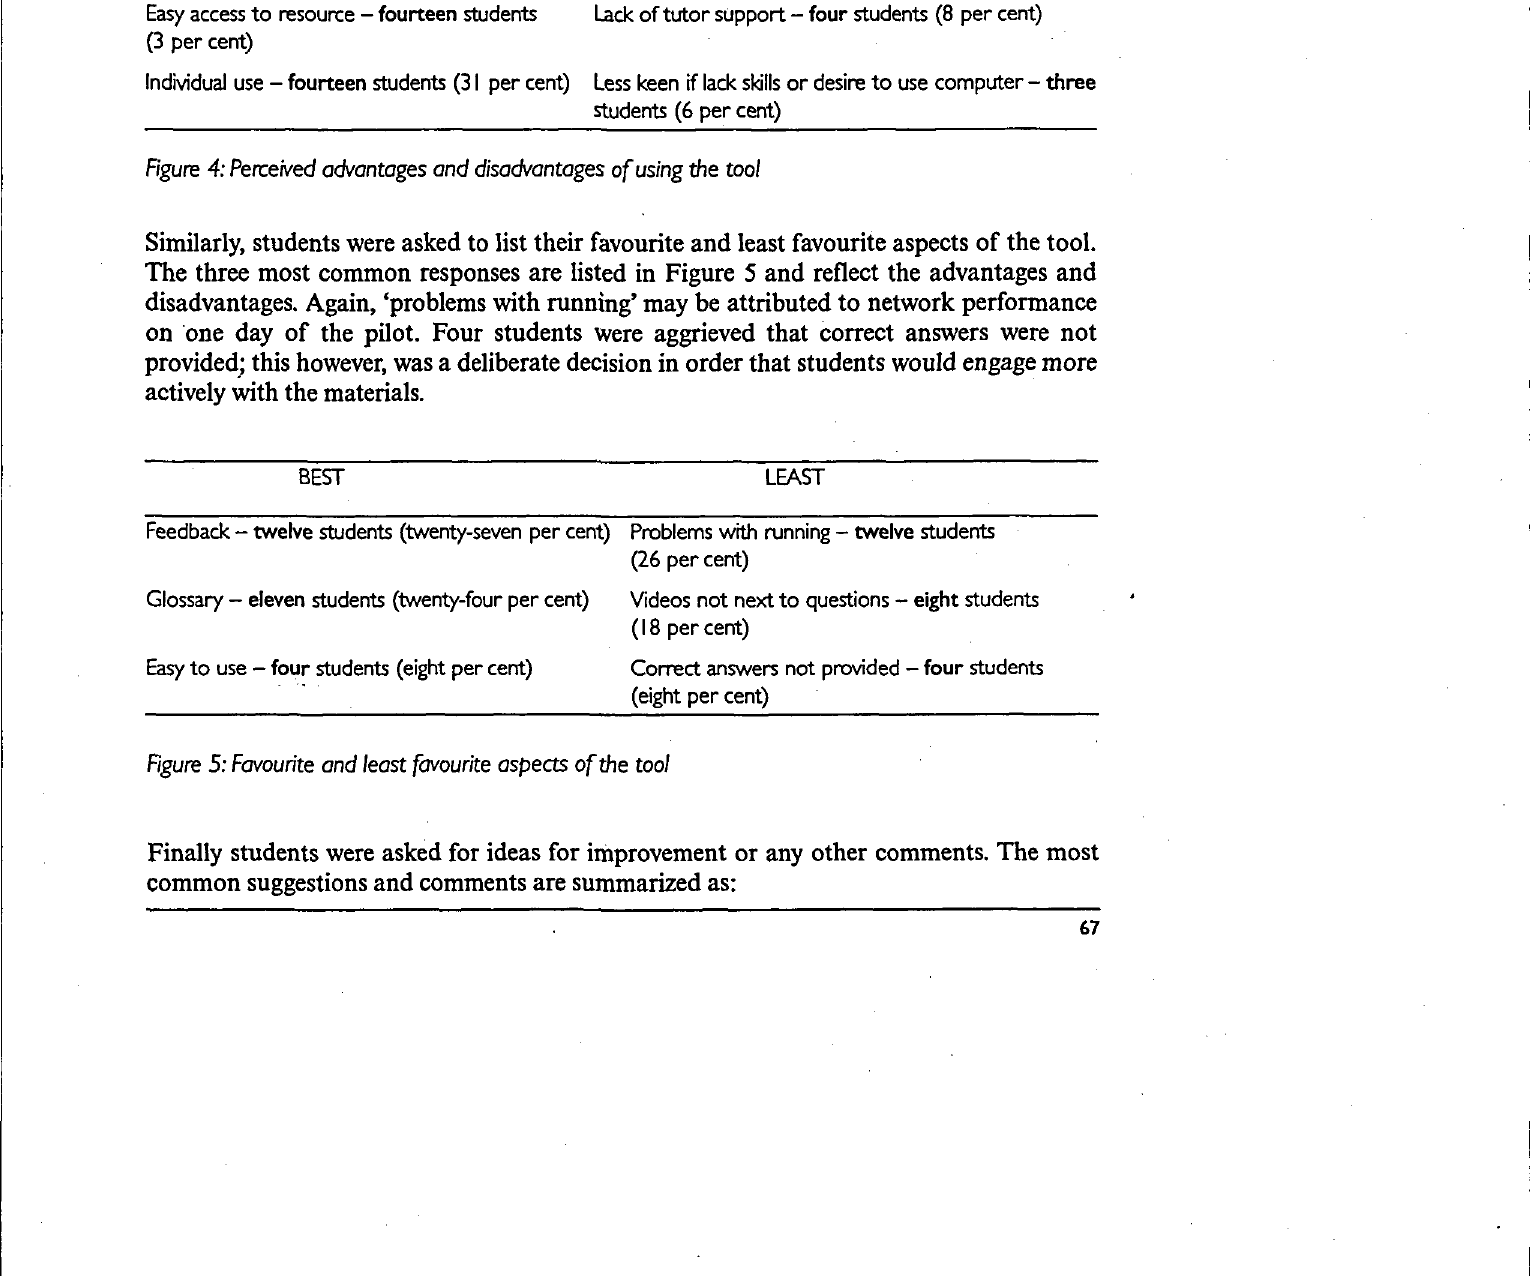
figure 4: Perceived advantages and disadvantages of using the tool